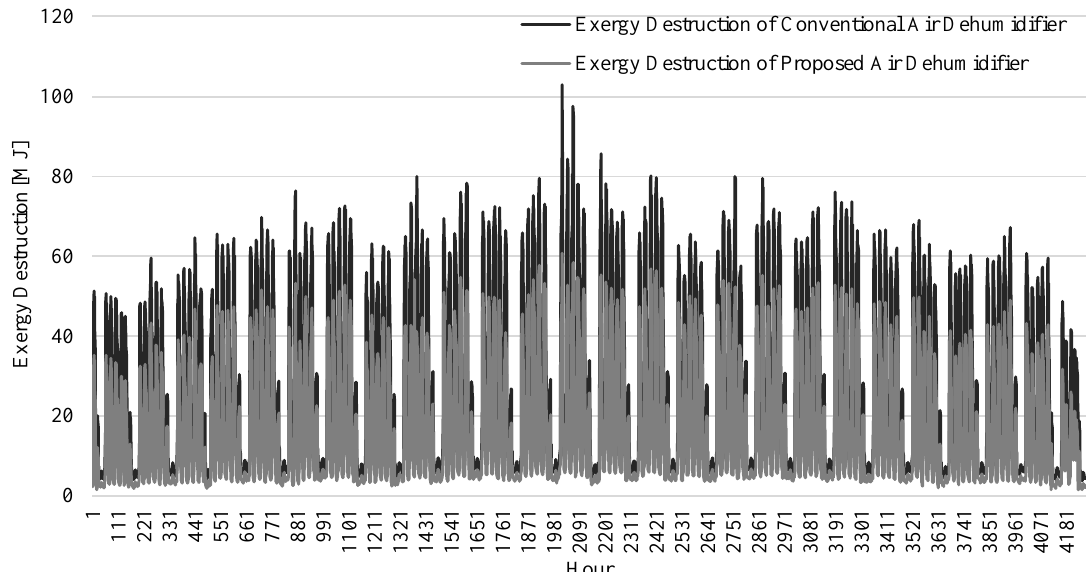
Figure 3. Quasi-dynamic exergy destruction in both air dehumidifiers